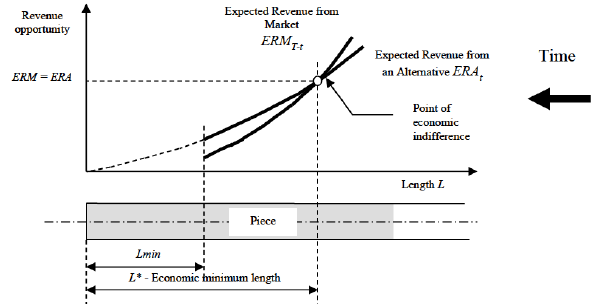
Figure 3: Variation of ERM